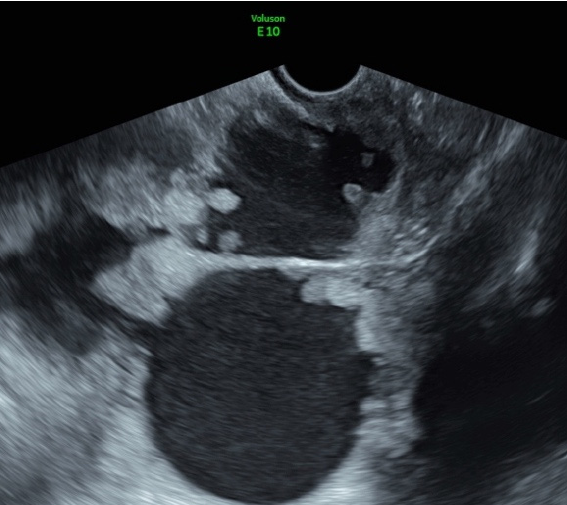
Figure 2. Transvaginal US picture of a multilocular-solid lesion with papillary projections (high-grade clear cell adenocarcinoma of the ovary).